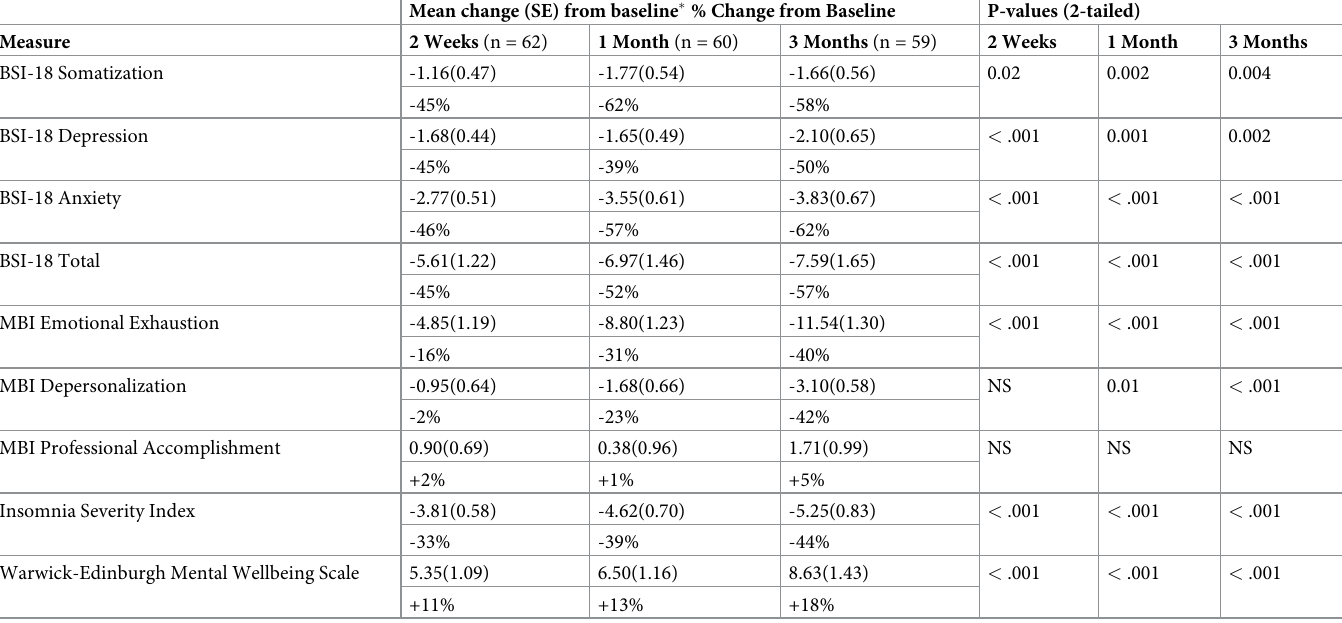
Data indicate change from baseline to each posttest visit and are reported as mean (standard error).